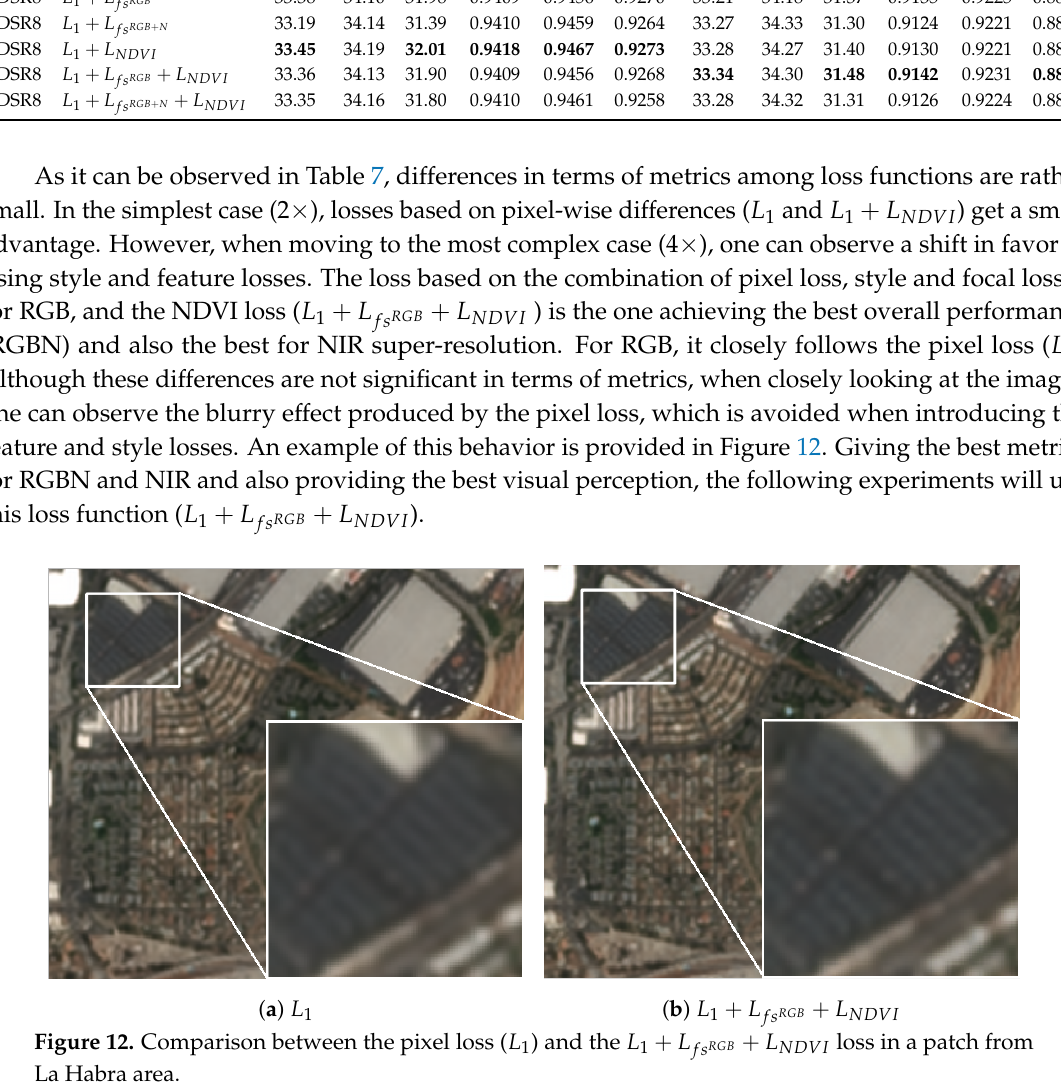
Table 7. Peak signal to noise ratio (PSNR) and structural similarity (SSIM) metrics obtained by the different loss functions in the test set using test-time augmentation (TTA). 2 × 4 × PSNR SSIM PSNR SSIM Model Loss Function RGBN RGB NIR RGBN RGB NIR RGBN RGB NIR RGBN RGB NIR EDSR8 L 1 33.42